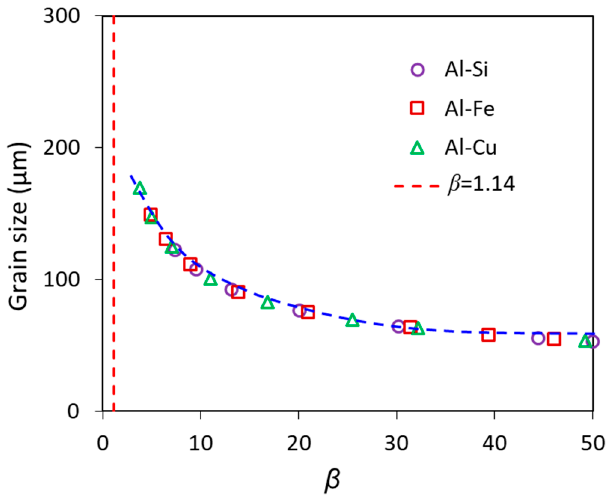
Figure 6. Calculated grain size as a function of growth restriction parameter, β , for Al alloys inoculated by potent TiB 2 particles ( N 0 = 1 × 10 13 m − 3 ) with a log-normal size distribution ( d 0 = 0.67 µ m and σ = 0.876) at Ṫ = 3.5 K/s [9]. Reprinted with permission from Ref. [9]. Copyright 2022 Elsevier.